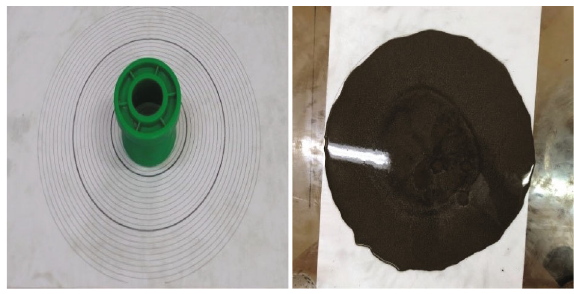
Figure 3: Determination of fl